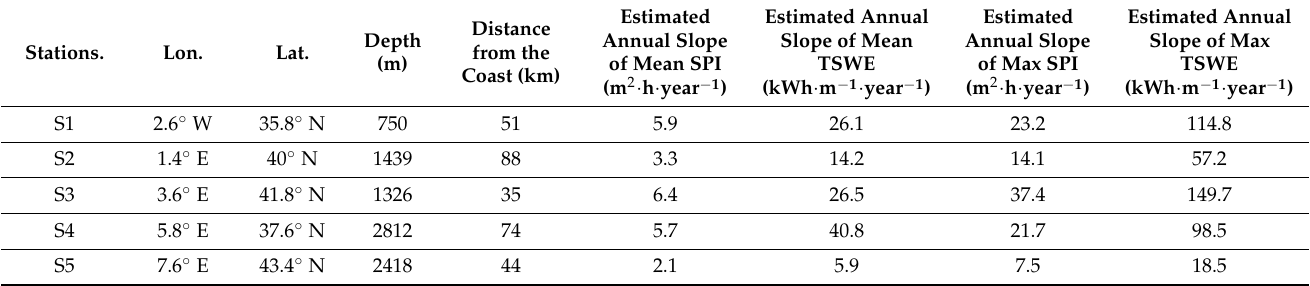
Table 3. Geographic information and estimated slopes of SPI and TSWE in five selected stations.